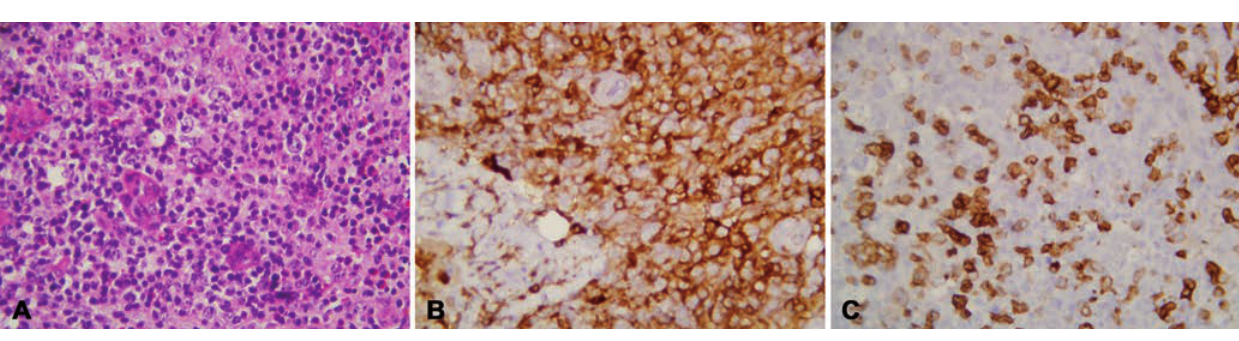
Figure 2. Lymph node biopsy revealing marked atypia and increased vascularity (A) with atypical T-cells staining positive for CD4 (B) and CD10